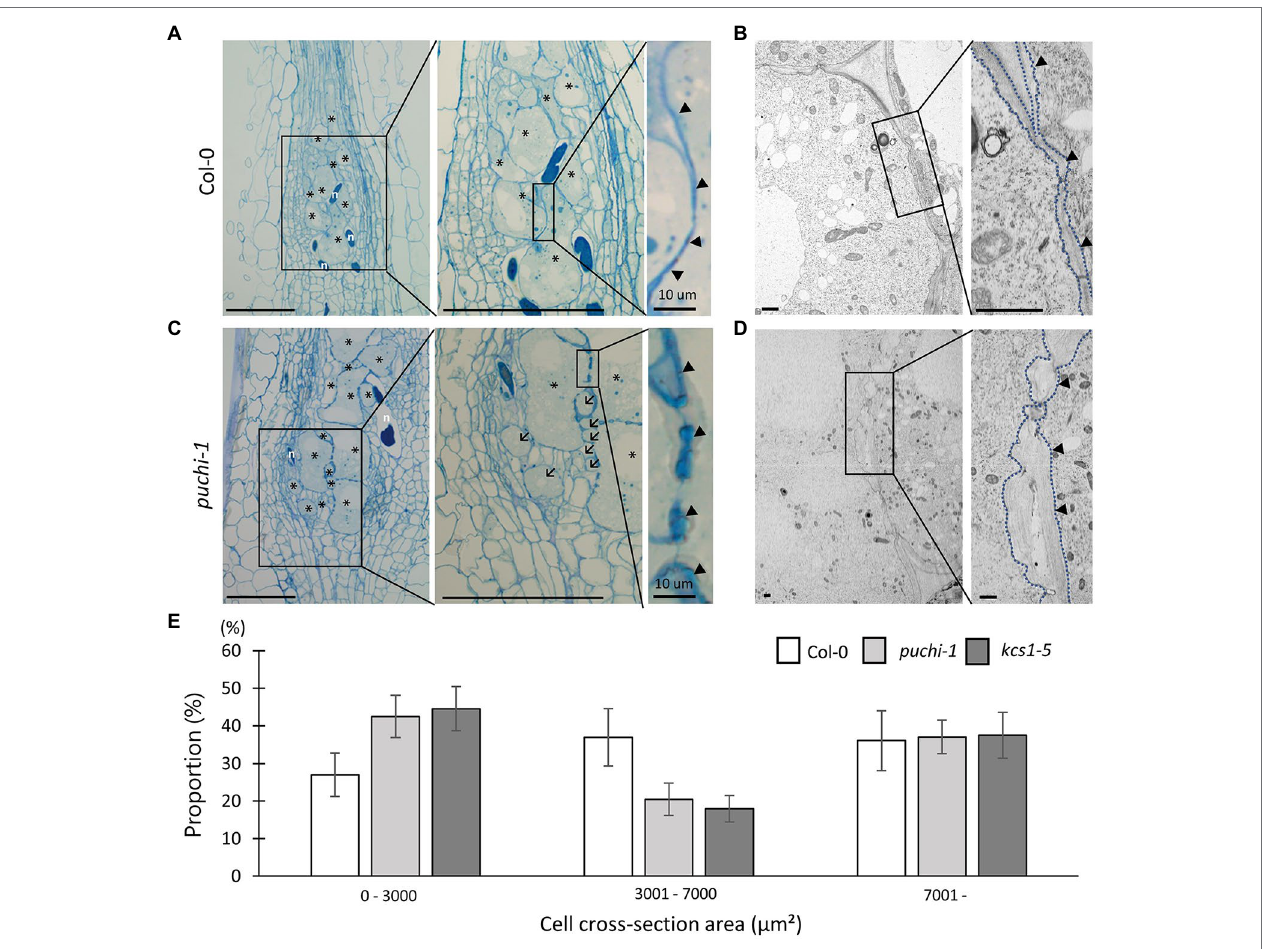
FIGURE 3 | Observation of WT and puchi-1 GC morphology. Morphological analysis of puchi-1 and WT GCs. (A, C) Toluidine blue-stained 7 dpi WT (A) and puchi-1 (C) gall longitudinal sections. Arrows denote aberrant GCs, and arrowheads denote cell wall thickening in Col-0 and puchi-1 galls. * denotes GCs; n denotes RKNs. Scale bars: 100 μ m. (B, D) TEM micrographs of WT (B) and puchi-1 (D) gall cross-sections. Blue dotted lines denote GC cell walls in Col-0 and puchi-1 GCs. Arrowheads denote cell wall thickening in Col-0 and puchi-1 GCs. Scale bars: 1 μ m. (E) Proportions of WT, puchi-1 , and kcs1-5 GCs with different cross-section area classes. Means ± standard deviation is shown. (WT: n = 12, puchi-1 : n = 15, and kcs1-5 : n =